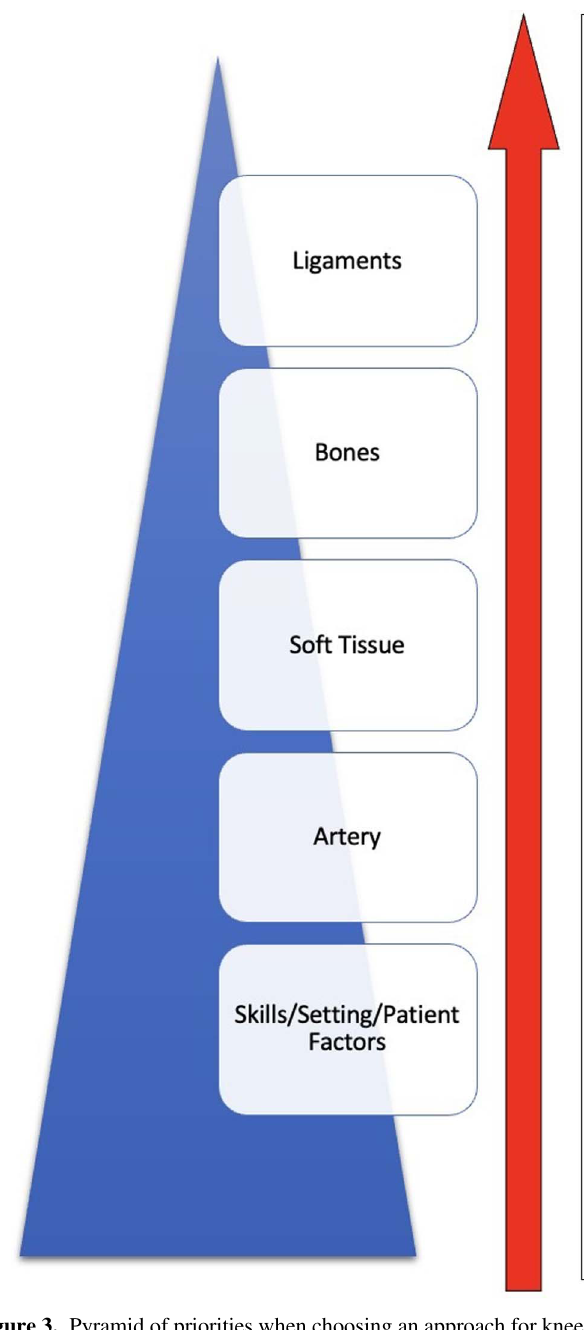
Figure 3. Pyramid of priorities when choosing an approach for knee ligament reconstruction. A summary of arguments for various approaches outlines the considerations when choosing an approach speci fi c to knee ligament reconstruction. The pyramid of priorities in order of importance includes life-threatening injuries, vascular compromise, soft-tissue damage, fractures, and ligamentous injury. Available skills, the setting and patient factors will in fl uence decision making at each